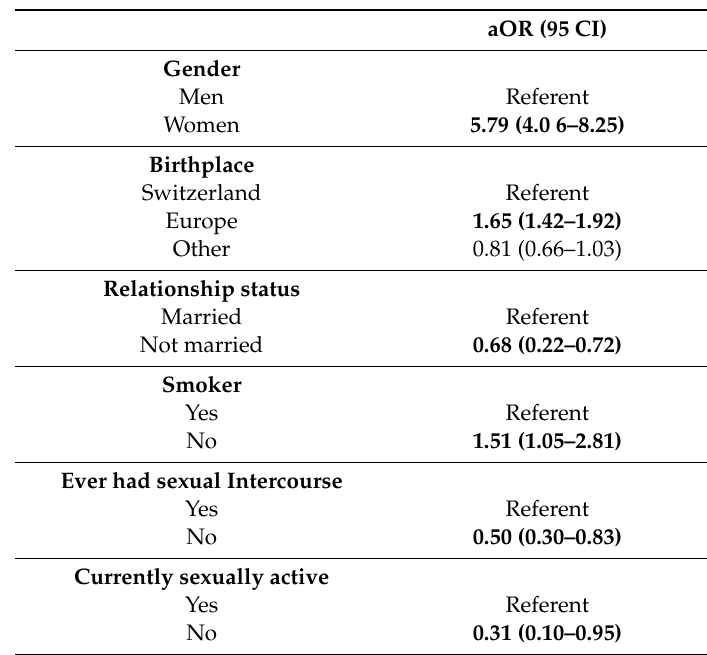
Table 4. Logistic regression predicting HPV vaccination (min one